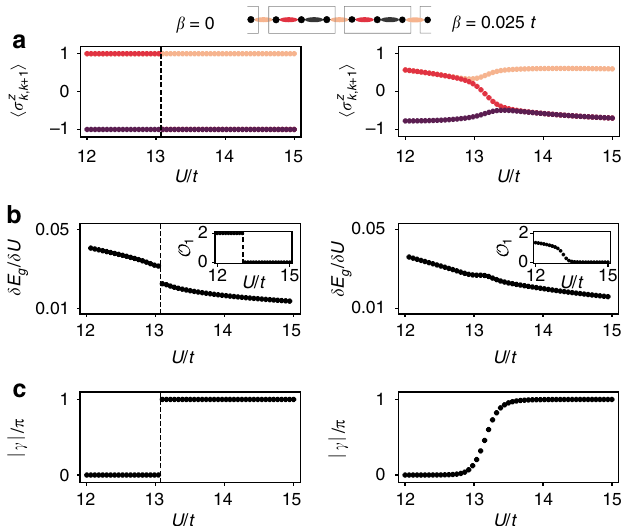
Fig. 3 Interaction-induced topological phase transitions: a unit-cell fi elds h σ z i as we increase U , where k ∈ {1, 2, 3} are the three different bonds. k ; k þ 1 The left and right panels correspond to β = 0 and β = 0.025 t , respectively. In the fi rst case, there is an abrupt transition between the trivial and topological BOW. In the second case, the transition is continuous, and we fi nd a fi nite region, where inversion symmetry is broken. b First derivative of the ground-state energy per unit cell E g through the transition. For β = 0, there is a discontinuous jump, signaling a fi rst-order topological phase transition. The inset shows also a jump in the observable O 1 . For β = 0.025 t , both quantities behave smoothly. c Total Berry phase, where the same behavior is observed. The results shown are obtained directly in the thermodynamic limit using iMPS (see the “ Methods ” section)